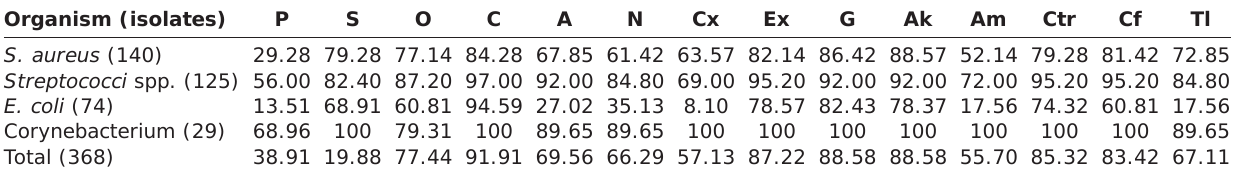
S. aureus=Staphylococcus aureus, E. coli=Escherichia coli , A=Ampicillin (25 mcg), Ctr=Ceftriaxone (30 mcg), Am=Amoxycillin (10 mcg), S=Streptomycin (25 mcg), Cx=Cloxacillin (30 mcg), C=Chloramphenicol (30